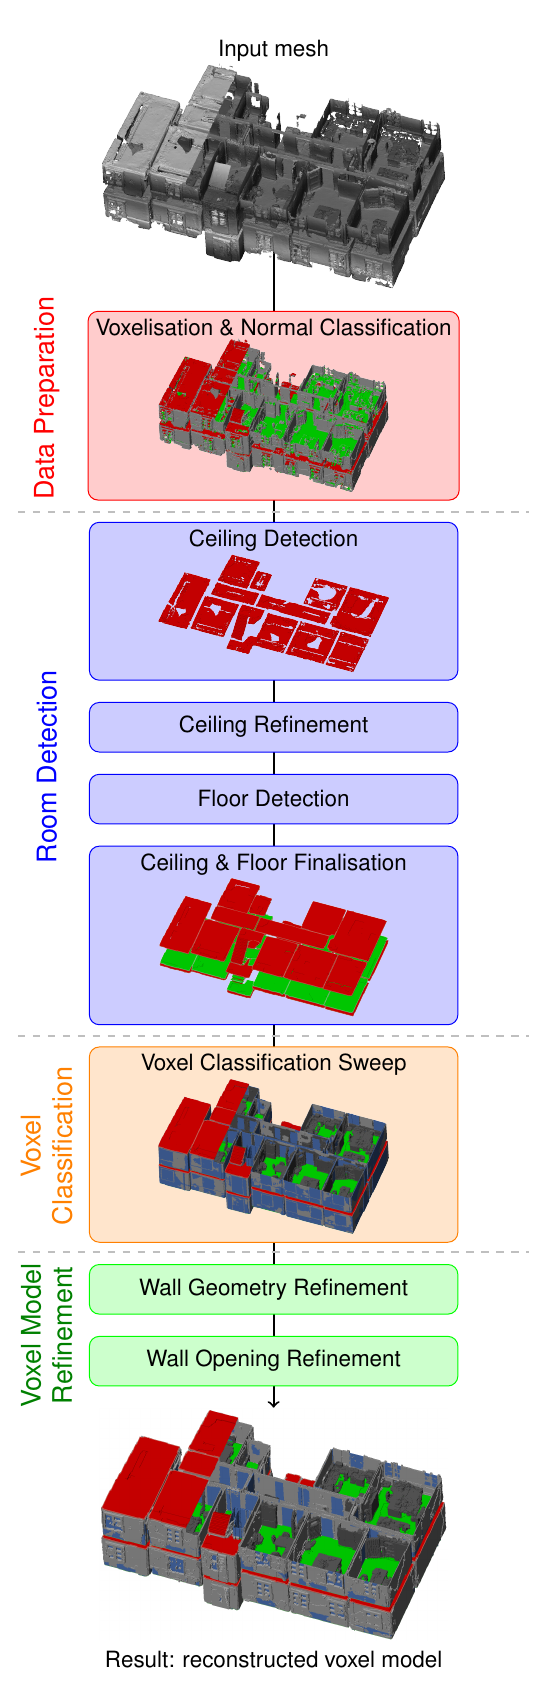
Figure 1. Processing workflow from input mesh to final recon- structed voxel model. The colour scheme of the normal classifica- tion is described in Table 1(a). The other depictions are coloured according to Table 1(b). A part of the ceiling is removed for the sake of visibility.